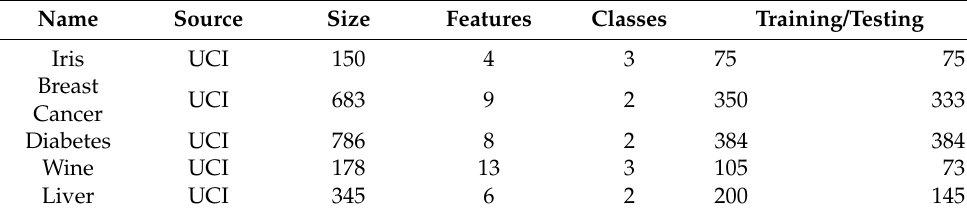
Table 2. Specification of the UCI benchmark Table 2. Speci fi cation of the UCI benchmark datasets.